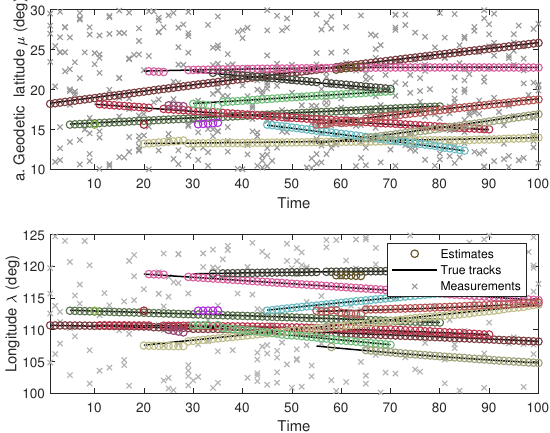
Figure 3. Tracking in longitudinal-latitudinal coordinates.